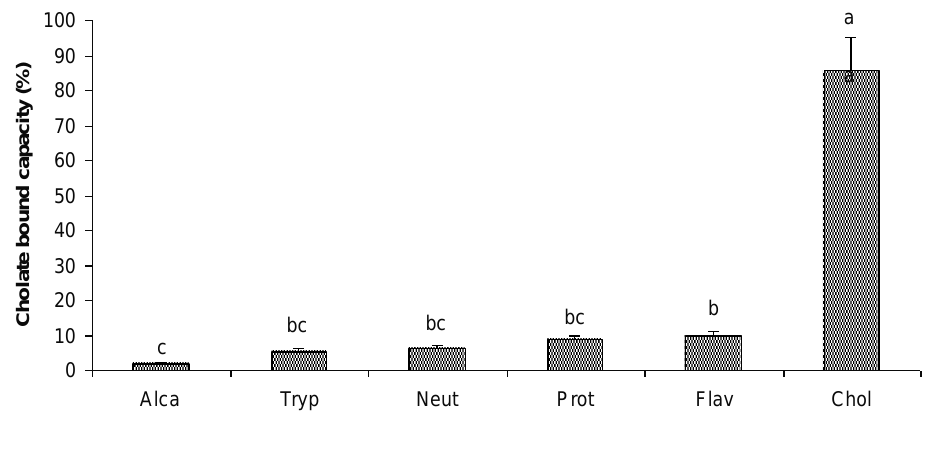
Figure 3. Sodium cholate binding by peptides from five differents hydrolysates of defatted corn protein. Alca: Alcalase; Tryp: Trypsin; Neut: Neutrase; Prot: Protamex; Flav: Flavourzyme. Cholestyramine (Chol) was used as a positive control. Different letters indicate significant differences ( p <